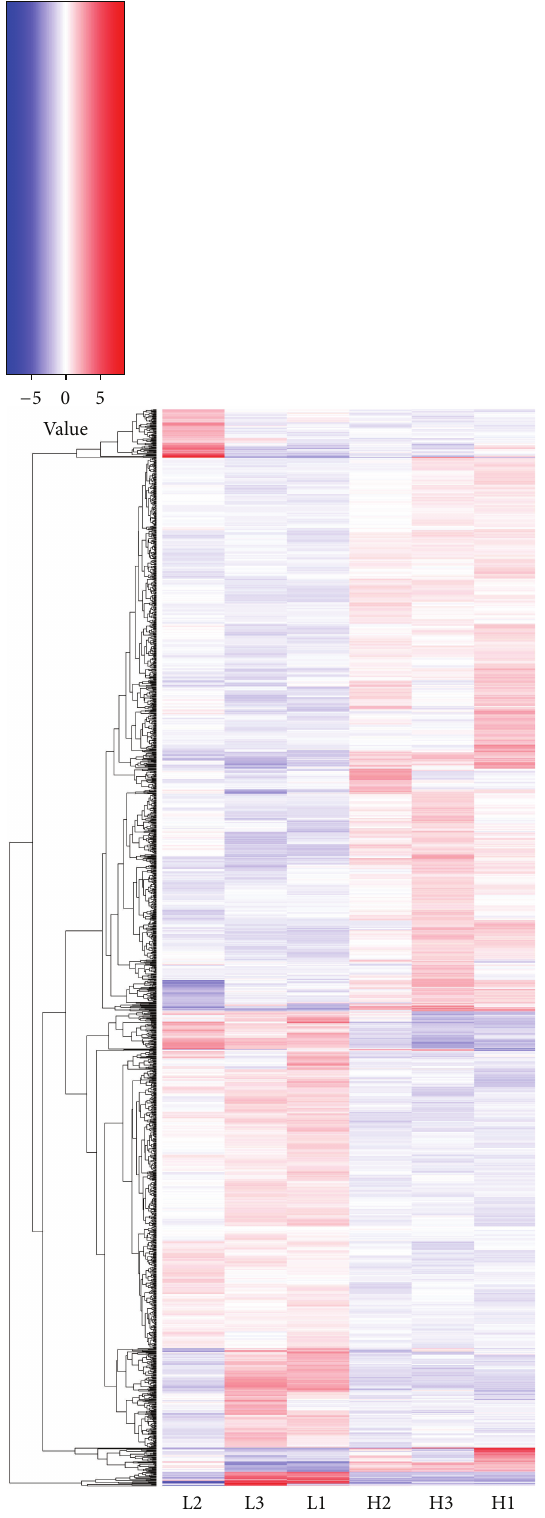
Figure 1: Cluster image of 1,694 significant differentially expressed transcripts between the high and low carcass fat content rainbow trout. A total of 1,694 differentially expressed transcripts were identified with Cufflink package based on FPKM: 912 were highly expressed in rainbow trout with high carcass fat content, and 782 showed higher expression level in those fish with low carcass fat content. H1, H2, and H3 represent the first, second, and third fish in the high carcass fat content group, respectively; and L1, L2, and L3 represent the first, second, and third fish in the low carcass fat content group, respectively. Colored bars indicate relative expression levels. Transcripts expressed at higher levels were assigned red, while transcripts expressed at low levels were assigned